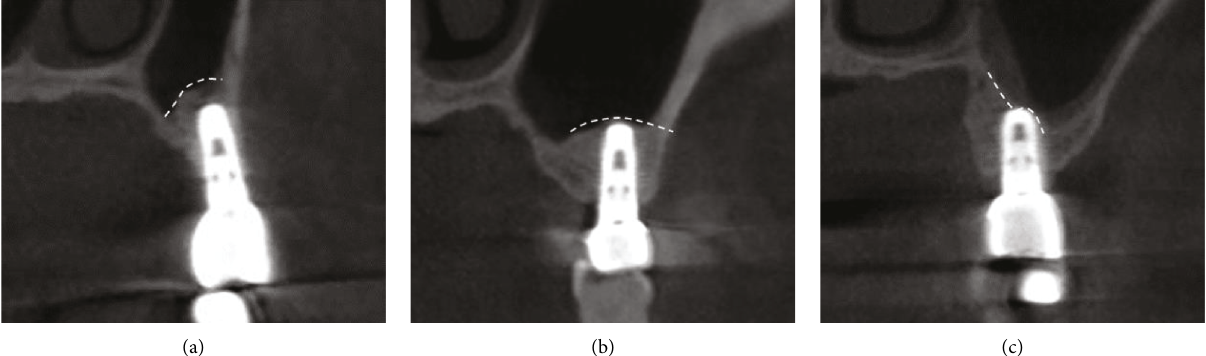
Figure 5: Classification based on the sagittal plane. (a) Type A’: tent type; (b) Type B’: flat type; (c) Type C’: one-sided dehiscence type.